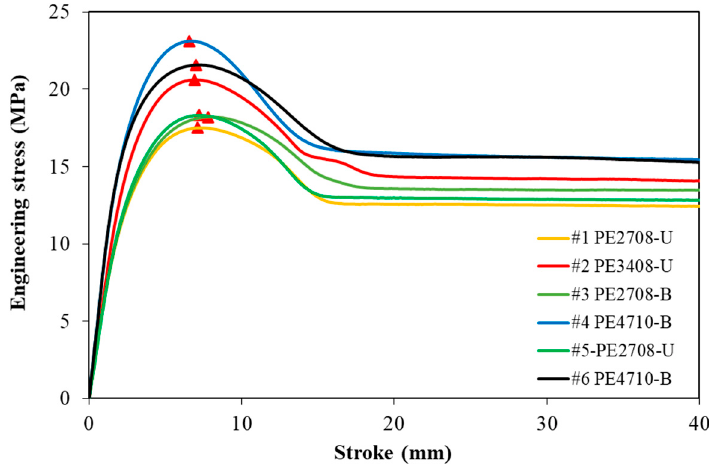
Figure 5. The engineering stress–stroke curves of the six PE pipes. (The red solid triangles mark the peak stress.)